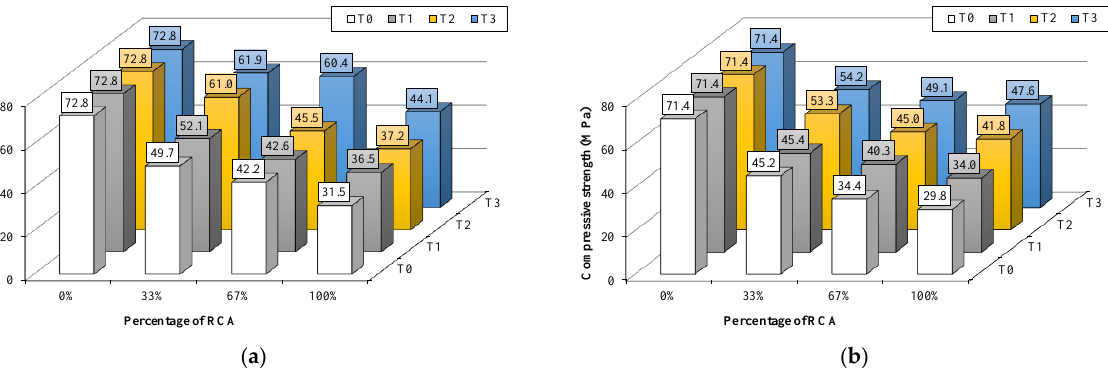
Figure 10. Compressive strength results of untreated and treated RCA for: ( a ) 10 mm aggregate; and ( b ) 20 mm aggregate.